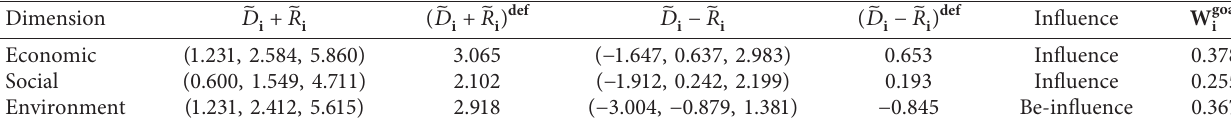
Table 19: Importance weight of sustainability dimensions in Z-number condition.